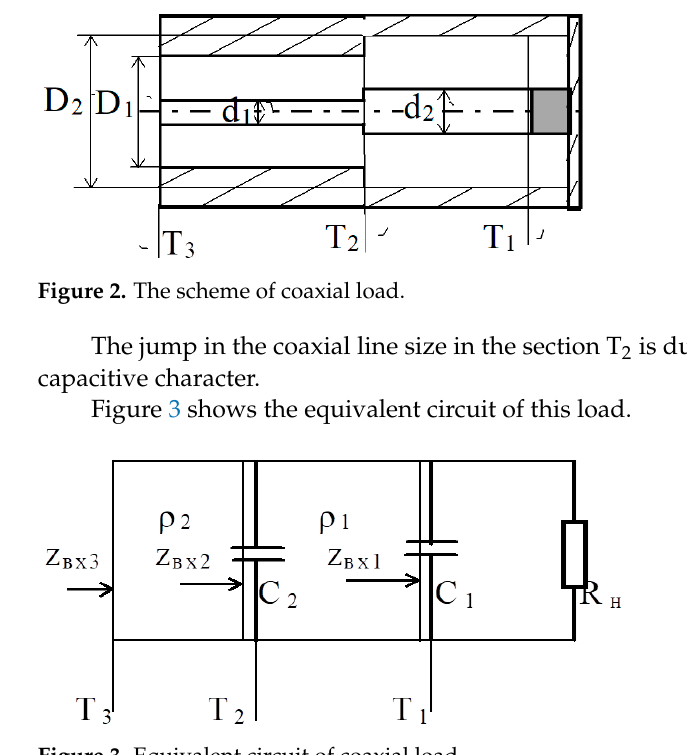
Figure 3. Equivalent circuit of coaxial load.